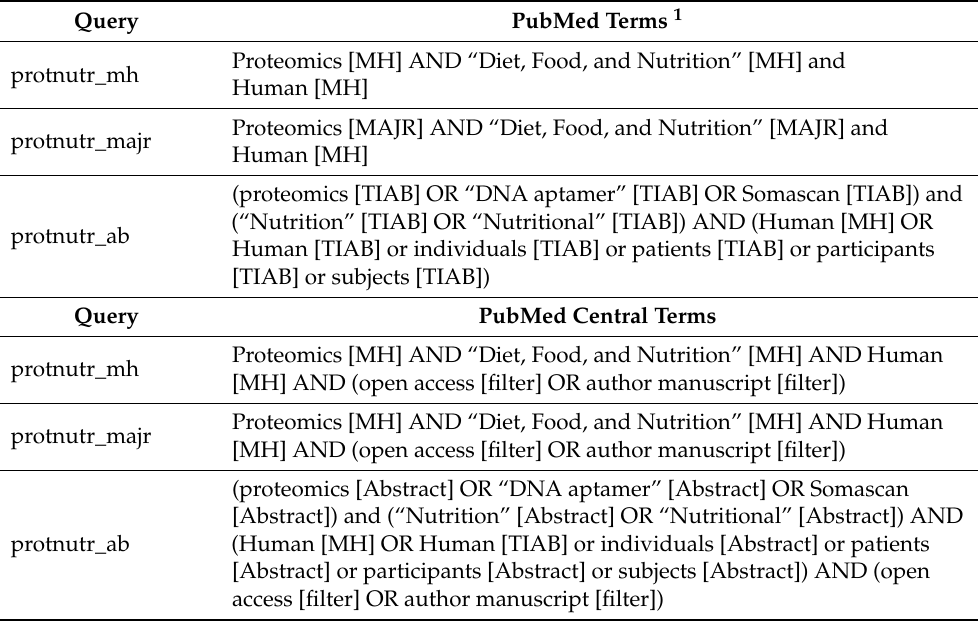
Table 1. Machine Reading Search